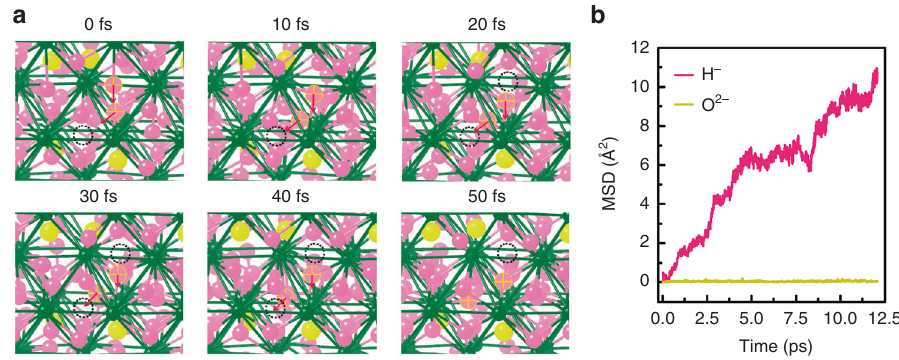
Fig. 4 Results of fi rst-principles molecular dynamics simulation. a Snapshot of simultaneous two-H − hopping. Green, yellow, and pink spheres represent La, O, and H atoms, respectively. Black circles are vacancy sites. b Calculated mean square displacement of H − (pink) and O 2 − (yellow)